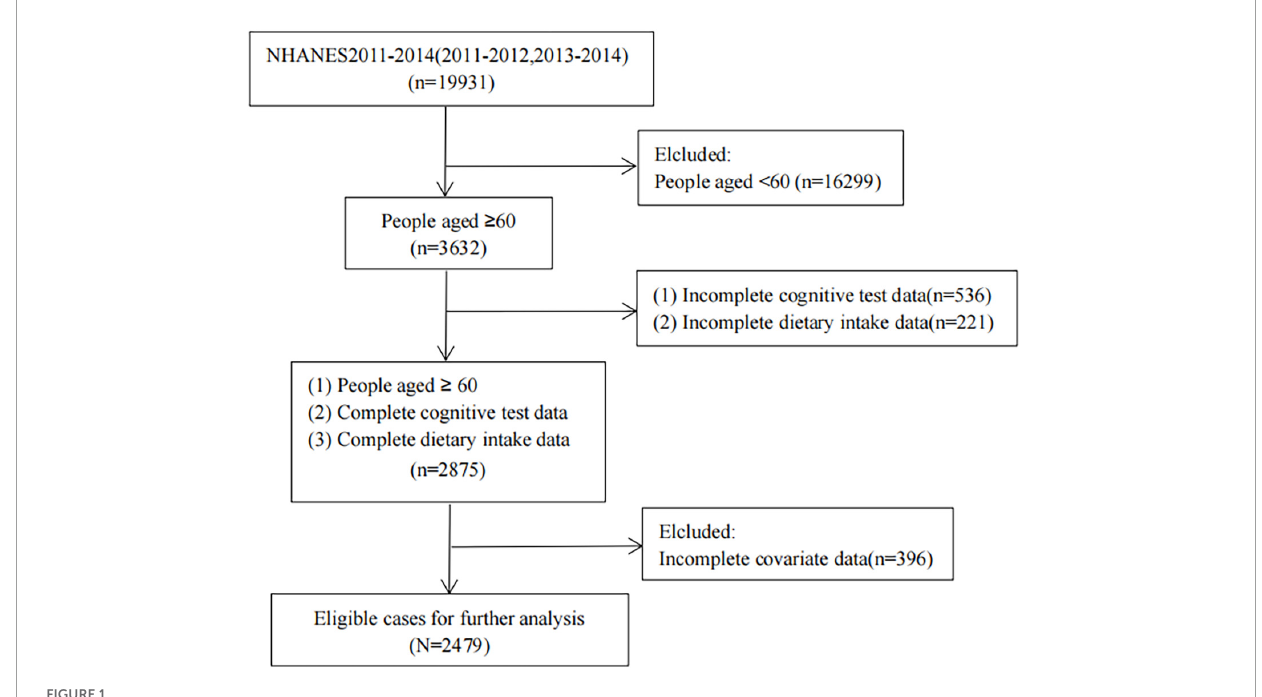
FIGURE1 Case inclusion